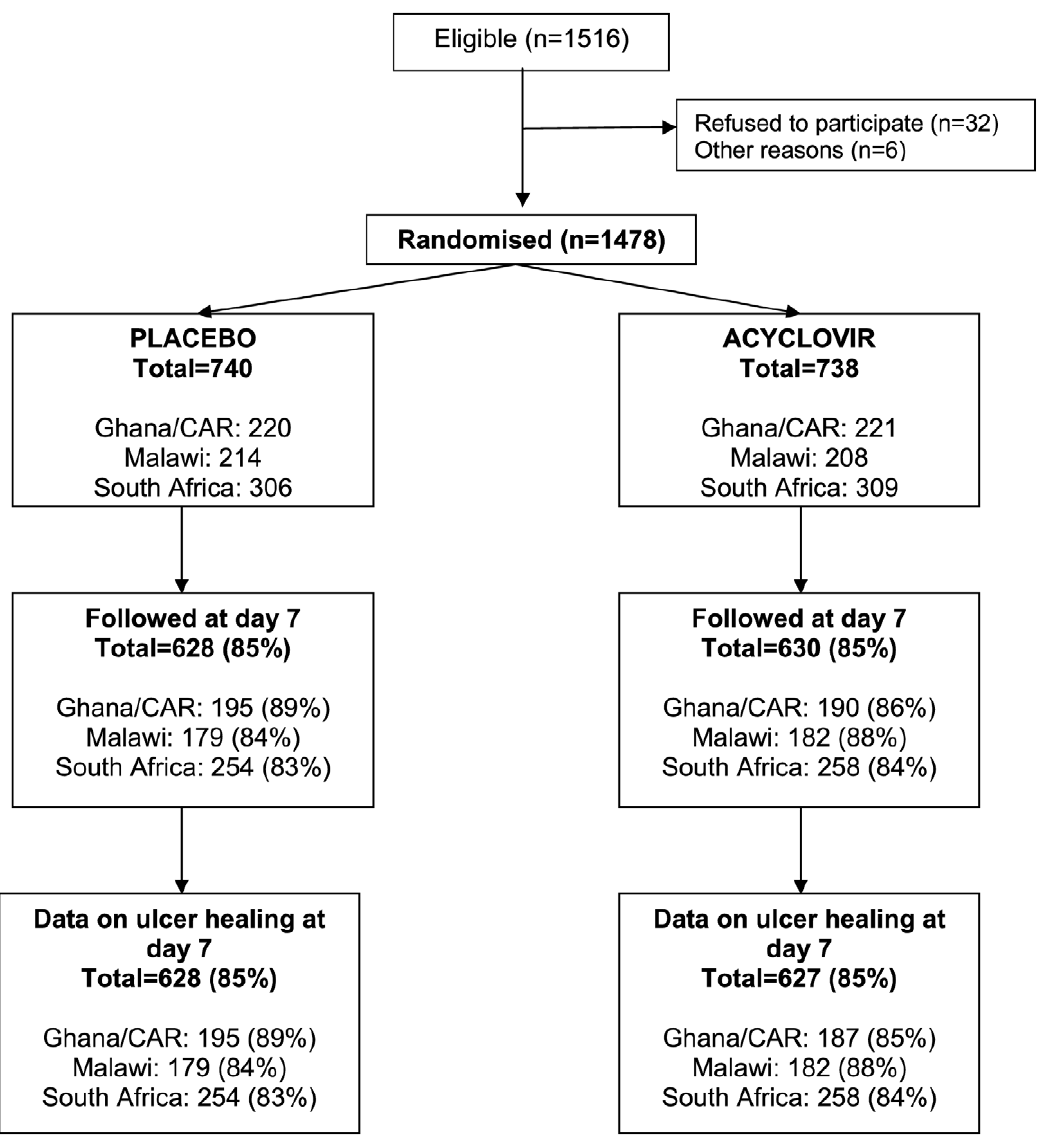
Figure 1. CONSORT flow diagram of eligibility, enrolment and follow-up in three African randomized controlled trials of episodic therapy for genital herpes.